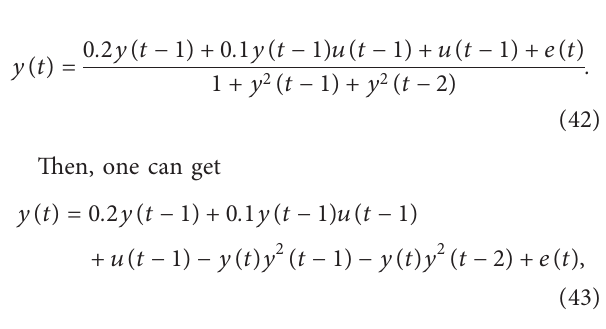
Figure 2: The parameter estimation errors τ versus. t